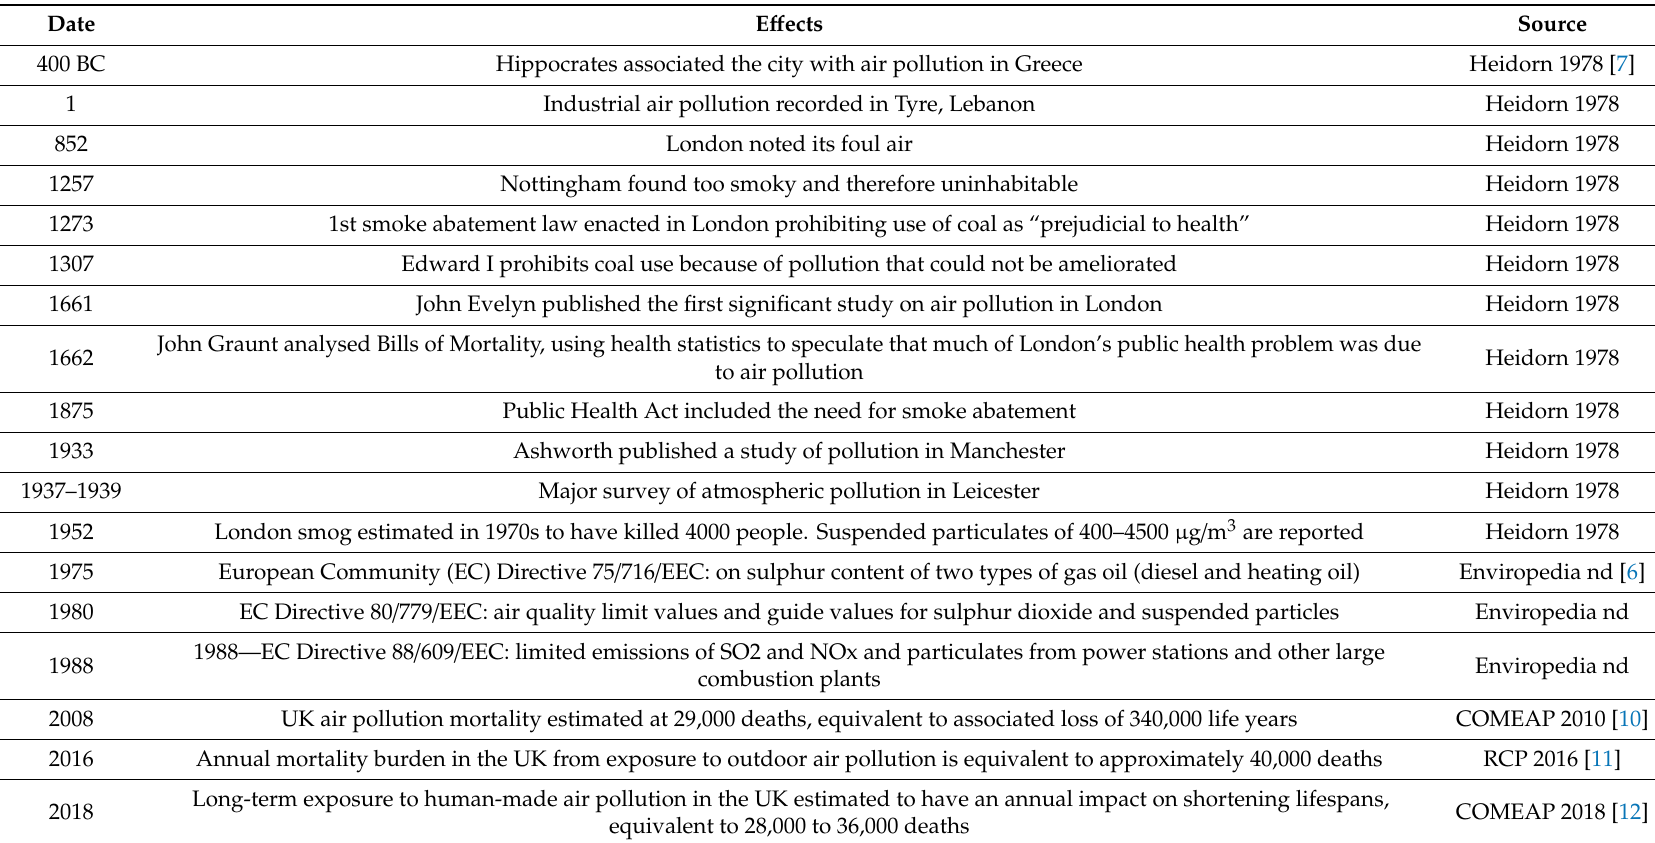
Table 1. Chronology on recognition of air pollution and its e ff ects—UK, unless otherwise